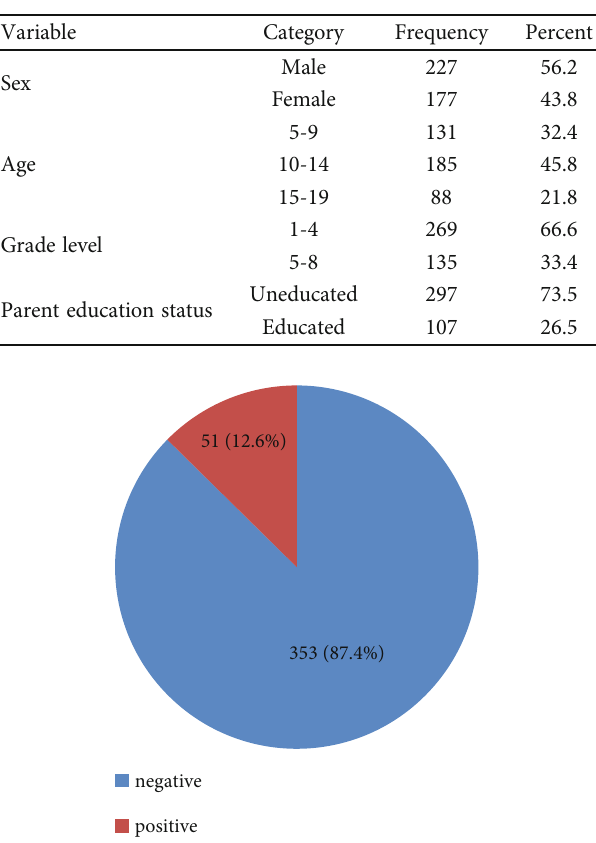
Table 1: Socio-demographic characteristics of the study participants study participants in Gichgich and Kibi, Guangua district, northwest Ethiopia (2019).